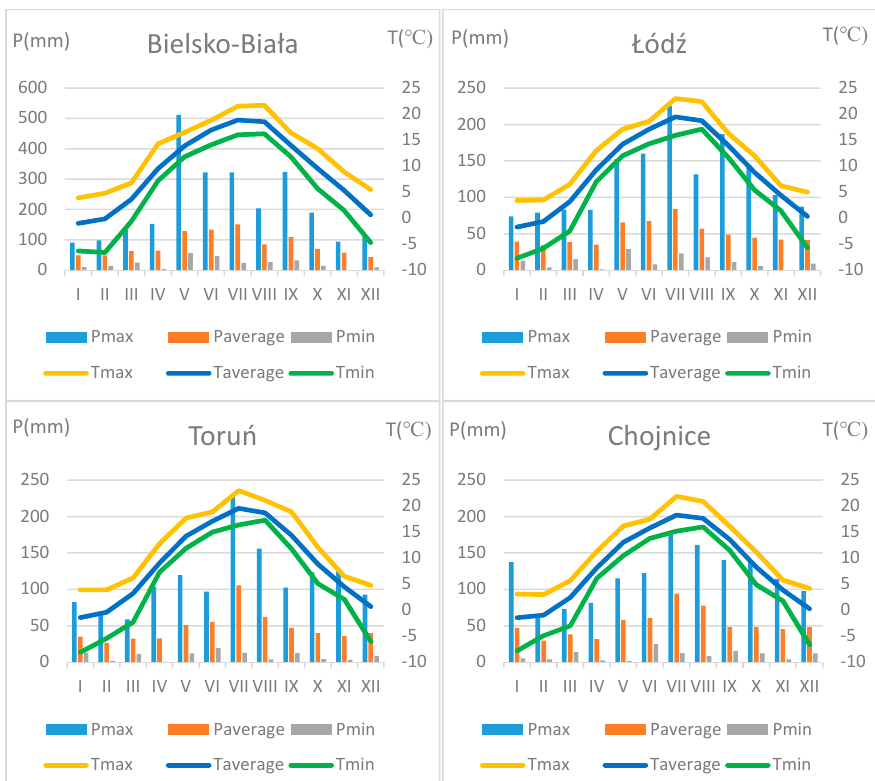
Figure 2. Average annual air temperatures (T) and precipitation (P) at selected meteorological stations in Poland in the period 1999–2018 (based on Institute of Meteorology and Water Management— National Research Institute data).